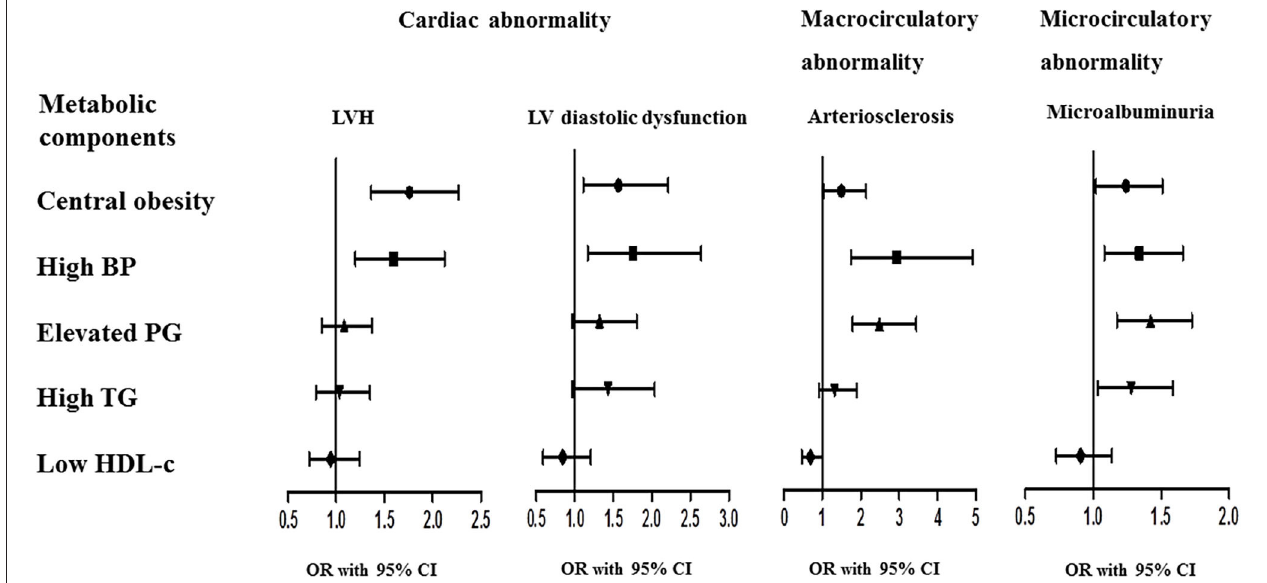
FIGURE 2 | Association of asymptomatic cardiovascular impairments with individual components of metabolic syndrome. The ORs and 95% CI were calculated to estimate the associations of various cardiovascular impairments with individual components of MS using binary logistic regression models, adjusted for age, sex, smoking status, family history of premature CVD, and the other four MS components.